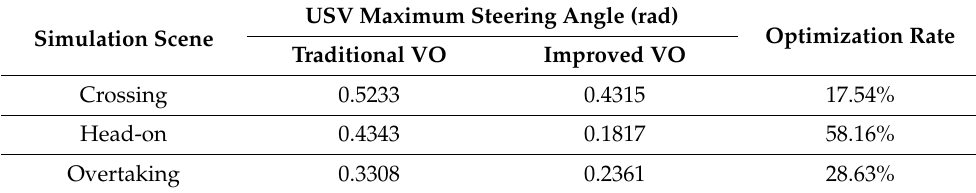
Table 4. Optimization rate of steering angle in obstacle